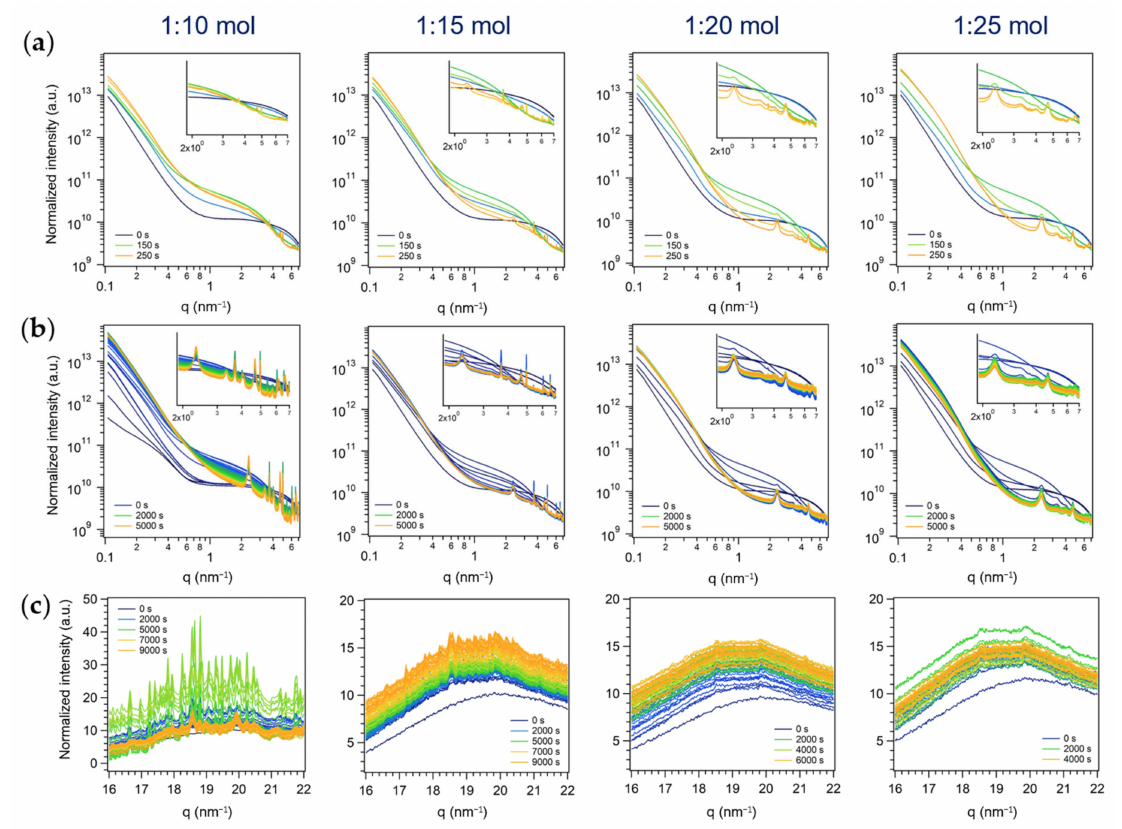
Figure 7. In situ time-resolved ( a , b ) log-log plots of SAXS and ( c ) simultaneous WAXS patterns of the series of experiments performed in ME with different AHM:HNO 3 molar ratios (first series of experiments). A SAXS pattern every 50 s from the start of acid addition (t = 0 s) to ( a ) the end of US (step iii) (t = 250 s) and to ( b ) 5000 s. Insets: zoom on Bragg peaks (1.9–7 nm − 1 ). ( c ) A WAXS pattern every 100 s from the start of acid addition (t = 0 s) to the end of